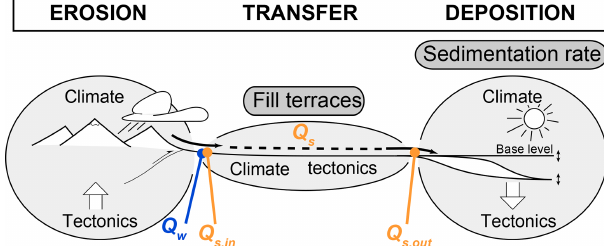
Figure 1. Schematic summary of a sediment-routing system and records of landscape evolution. Sediment-routing systems are typ- ically subdivided into three zones: the sediment production (ero- sion) zone, the sediment transfer zone, and the sediment deposition zone (Allen, 2017; Castelltort and Van Den Driessche, 2003). As sediment production is thought to vary with environmental con- ditions, changes in those conditions might be preserved in sedi- mentary records in the transfer zone (e.g., fill terraces) or deposi- tion zone (e.g., sedimentation rates). Complications arise, however, as alluvial rivers within the transfer zone continuously adjust their channel geometry to the incoming water discharge ( Q w ) and sedi- ment supply ( Q s , in ) through sediment deposition or remobilization and thus modify the sedimentary signal. The amount of upstream sediment supply combined with additional sediment remobilized within the transfer zone minus the amount of sediment deposited in the transfer zone determines how much sediment is discharged from the transfer zone to the deposition zone ( Q s , out ). Figure mod- ified from Castelltort and Van Den Driessche